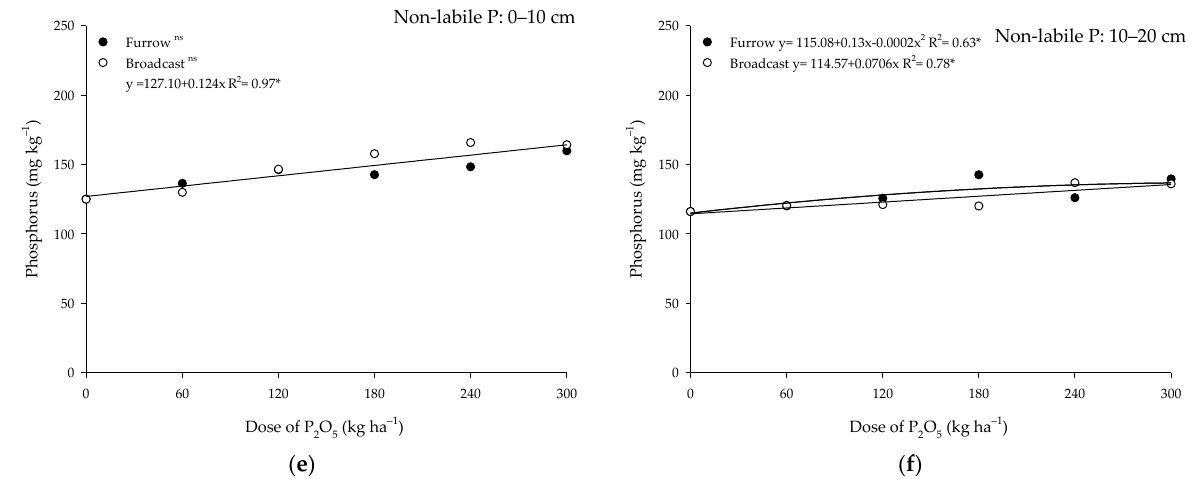
Figure 5. ( a , b ) Labile P, ( c , d ) moderately labile P, ( e , f ) and non-labile P fractions at 0–10 and 10–20 cm soil layers, respectively, after six years of annual phosphate doses application at seed furrow or broadcasted. *: significant at 5%; ns: not significant. The labile and moderately labile P fractions relative to the total P in the soil increased proportionally to the increase in P doses applied, which was more evident at 0–10 cm, but was also detected at 10–20 cm (Figures 5a–d and 6). Considering the average of P application mode (seed furrow or broadcast), labile P (Pi AER + Pi BIC + Po BIC ) represented 9.4 to 20.1% of the soil total P at 0–10 cm, and 9.6 to 12.3% at 10–20 cm, for doses from 0 to 300 kg ha −1 of P 2 O 5 , respectively. Moreover, the moderately labile P fraction (Pi HID-0.1 + Po HID-0.1 + P HCl ) represented 32.1 to 42.4% of the soil total P at 0–10 cm and 33.5 to 41.9% at 10–20 cm, which was also contrasted according to the doses from 0 to 300 kg ha −1 of P 2 O 5 , respectively. Those results are in accordance with Rodrigues et al. [3], in which the labile P represented <20% of total P and moderately labile varied from 27 to 36% in cultivated areas of Brazilian Cerrado. Otherwise, higher doses of P resulted in lower proportions of soil non-labile P fractions (Pi HID-0.5 + Po HID-0.5 + P residual ) relative to the total P (Figure 5e–f). The non-labile P constituted the greatest proportion, representing 38.5 to 58.5% at 0–10 cm and 45.8 to 56.9% at 10–20 cm, with a small but significant increment according to increasing P fertilizer dose. Similarly, other authors [3,34,35] verified that non-labile P fractions constituted the largest fraction of the total P in the soil, representing, in general, more than 50% of the total P.